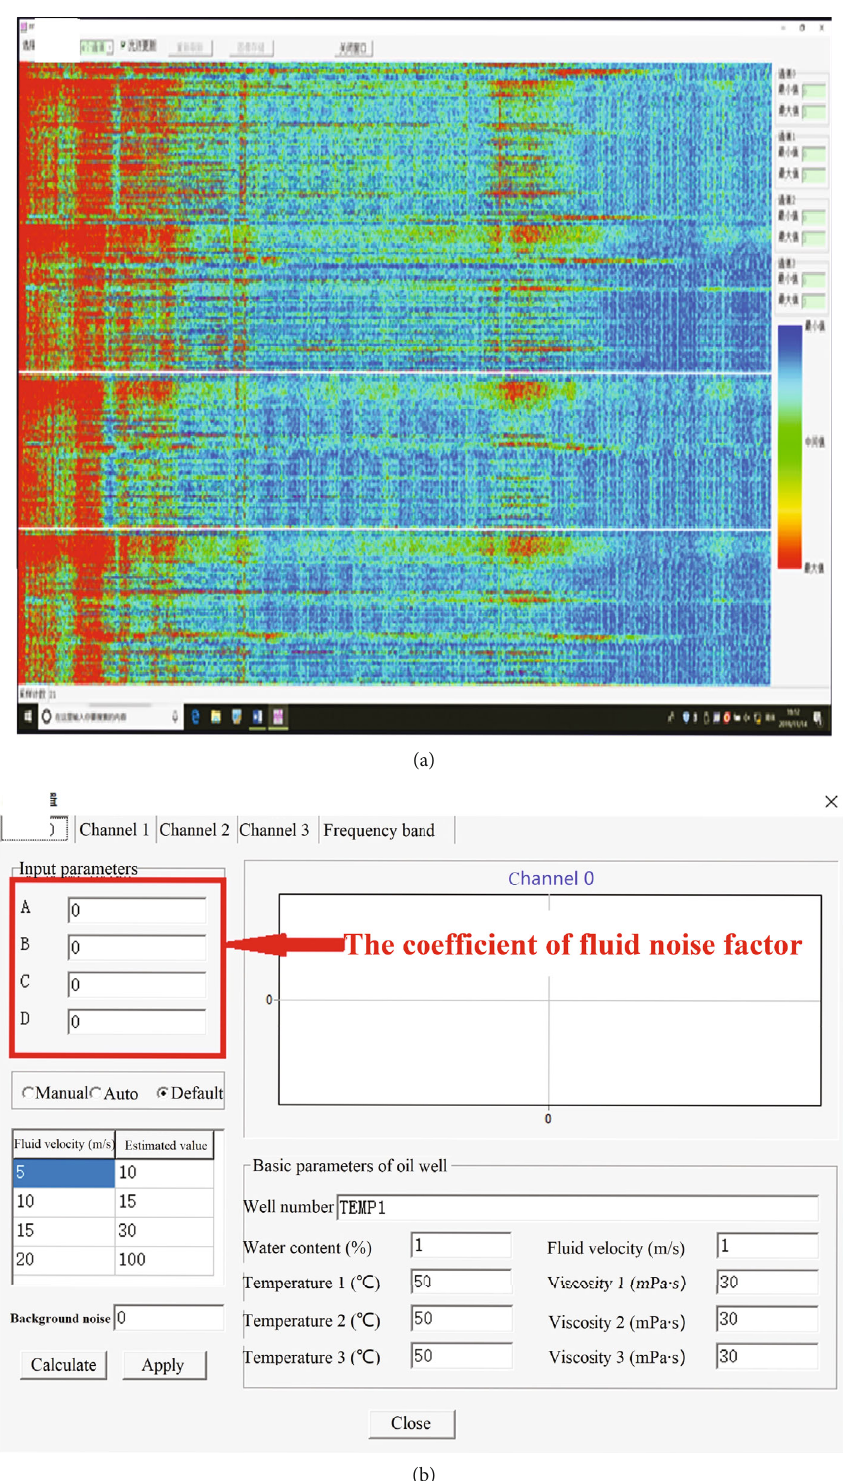
Figure 8: Sand production monitoring software system: (a) dynamic time spectrum; (b) sand monitoring